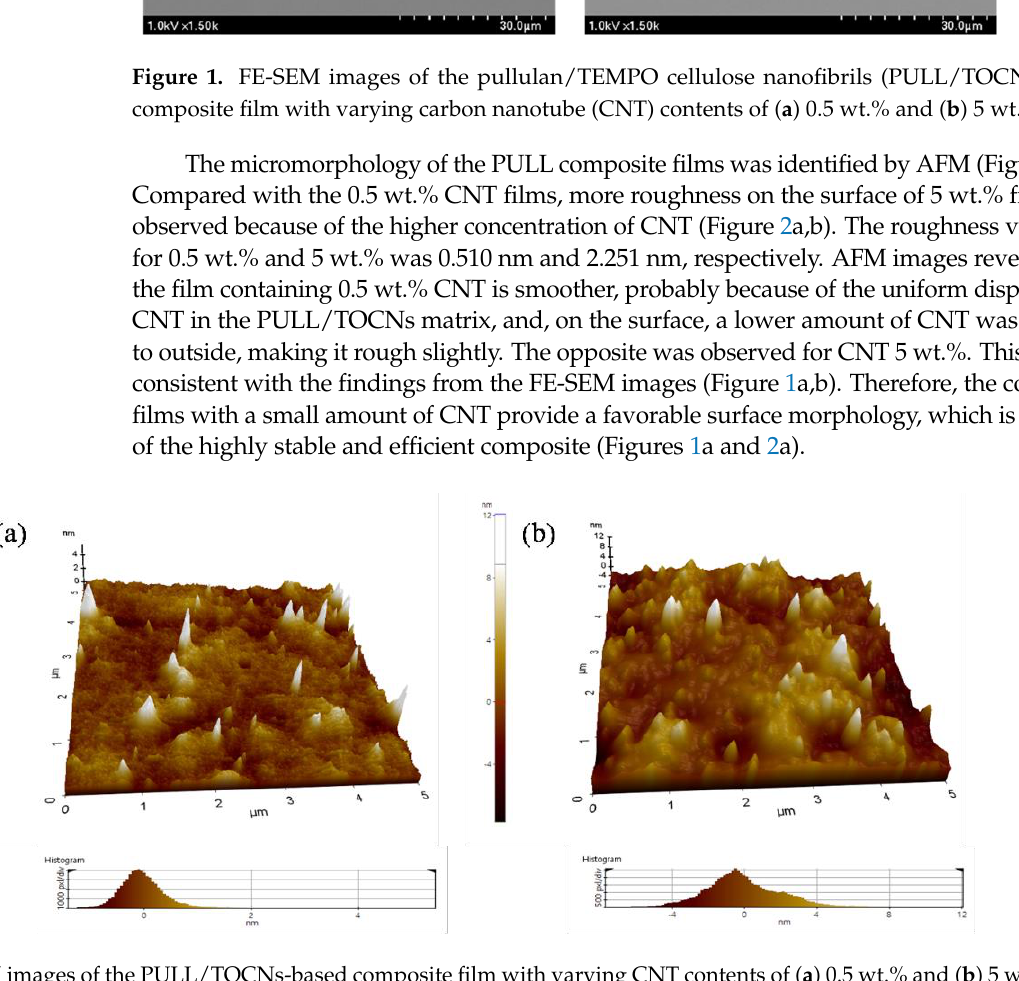
Figure 2. AFM images of the PULL/TOCNs-based composite film with varying CNT contents of ( a ) 0.5 wt.% and ( b ) 5 wt.%.